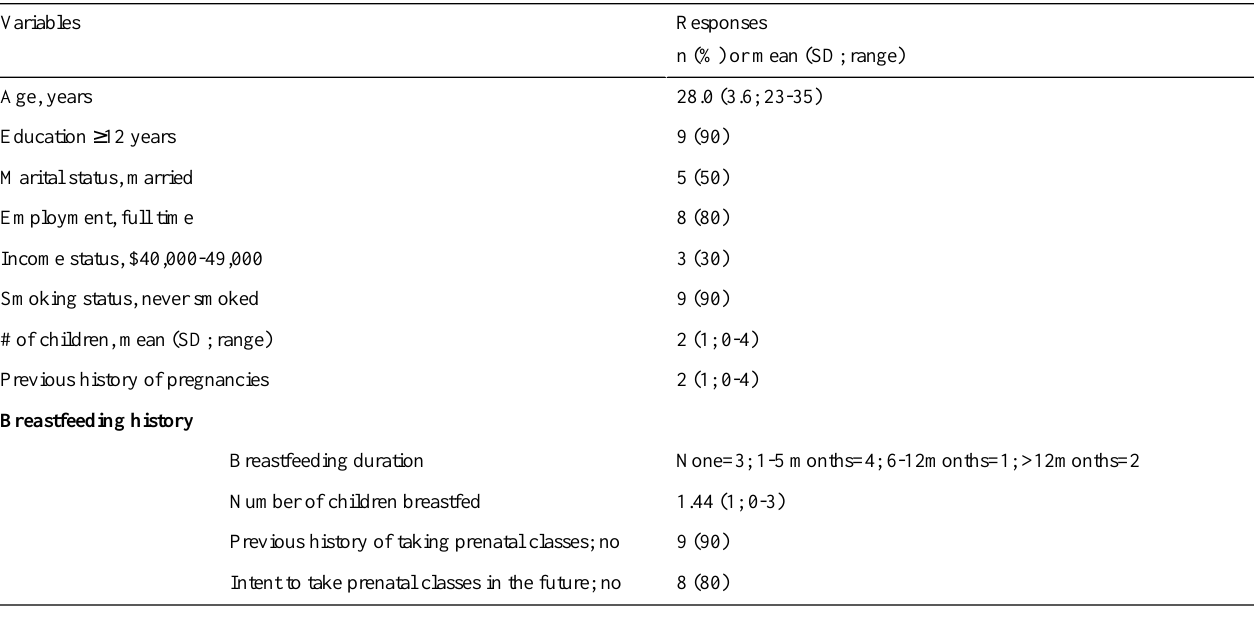
Table 2. Study population characteristics (N=10).